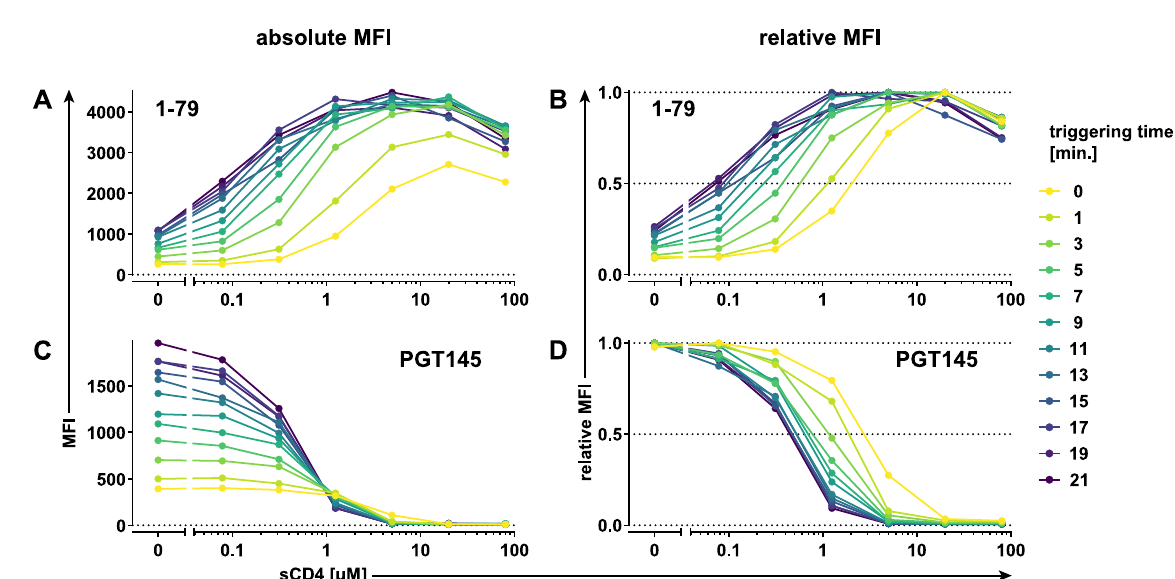
Fig 2. Time resolution of on-cell sCD4 triggering to define basal epitope exposure curves. Time resolution of on-cell sCD4 triggering of BaL.01 Env. Binding efficacy of V3 crown mAb 1–79 (A, B) and V2 apex bnAb PGT145 recognizing a quaternary epitope (C, D) (both at 0.1 μ g/ ml) in response to increasing sCD4 at different time intervals. MFI staining curves (A, C) or MFI staining curves normalized to their maxima (relative MFI staining curves) (B, D) derived as described in Fig 1 are plotted for all individual time points. Histogram plots of the event distributions underlying the above MFI values are depicted in S2 Fig. Data represent a single experiment. bnAb, broadly neutralizing antibody; Env, envelope glycoprotein; mAb, monoclonal antibody; MFI, mean of fluorescence intensity; sCD4, soluble CD4; V2, second hypervariable; V3, third